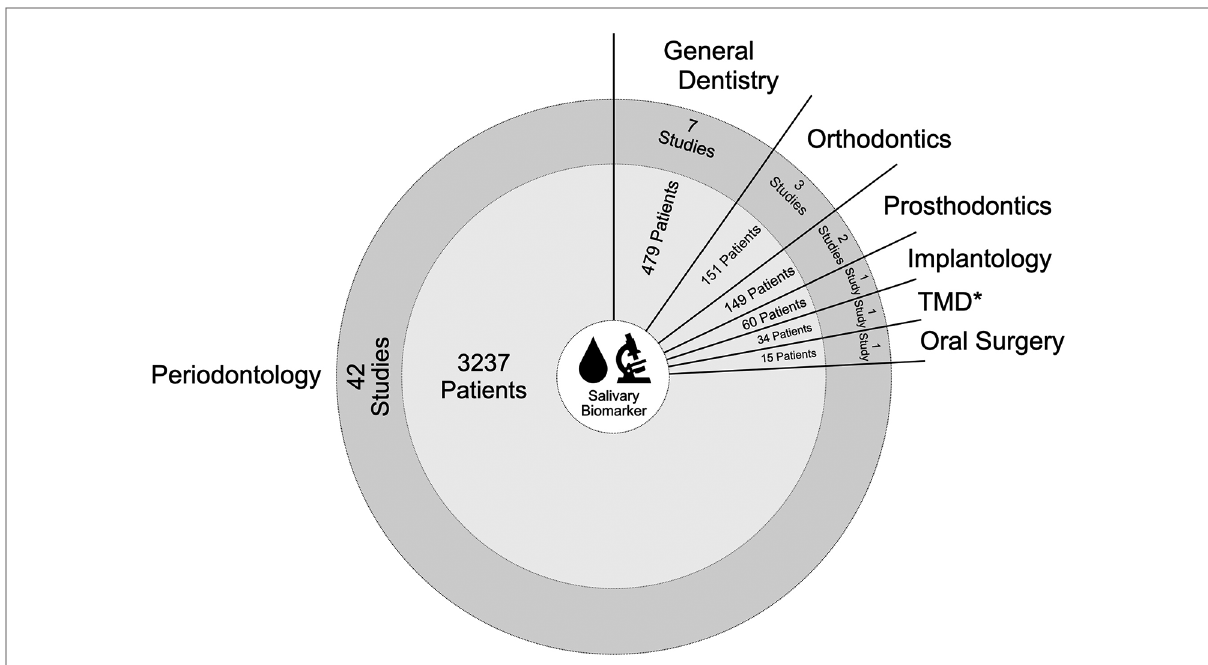
FIGURE 2 Map of data items associated with number of studies related to dental disciplines including patients involved (* TMD=temporo-mandibular disorder).